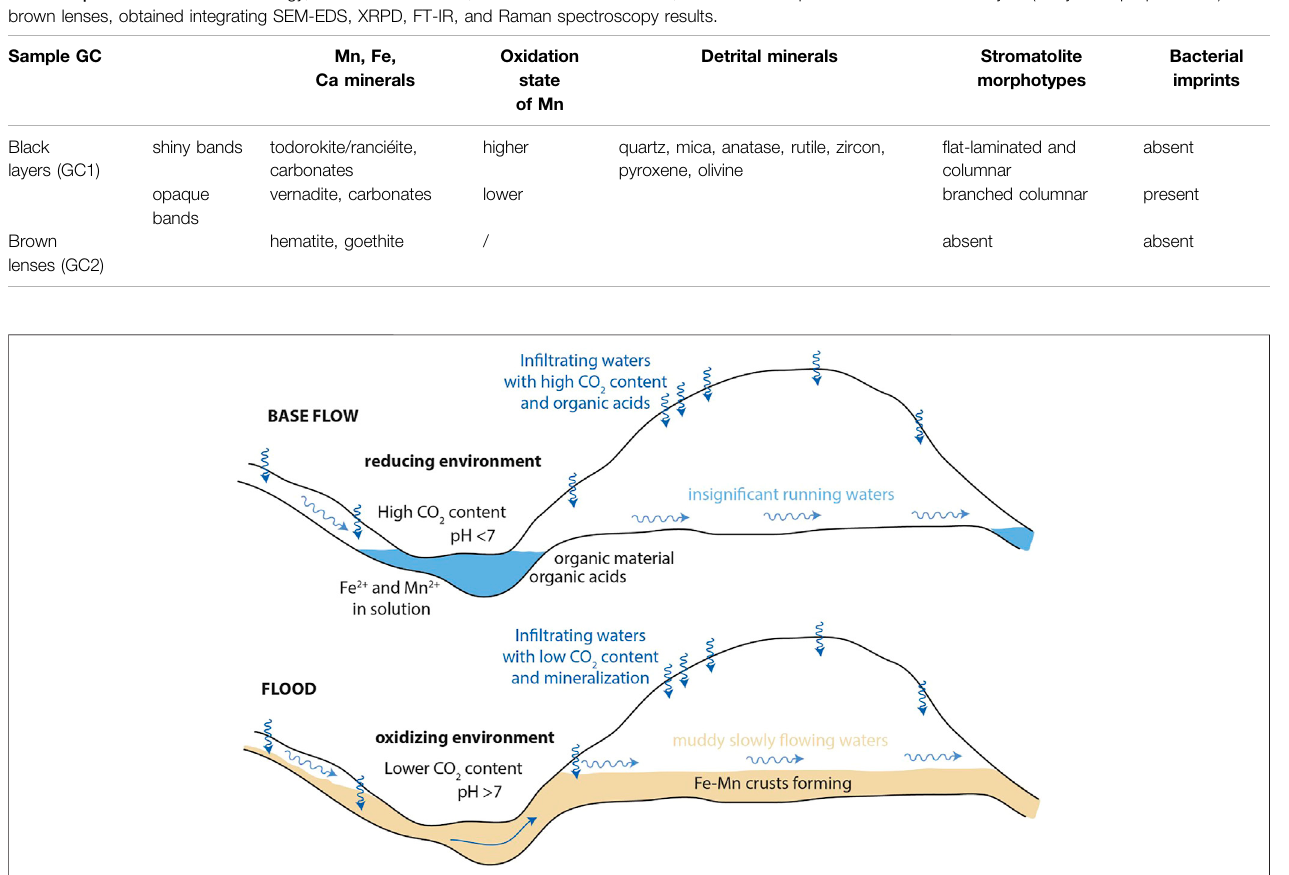
FIGURE12| DepositionalmodelproposedfortheMnFepatinas.Duringbase fl owhydrologicalconditions(upperpanel),thestudiedkarstsystemdrainsin fi ltrating waterwithnosigni fi cantincreaseofundergroundwaterlevel.Patinasformduringrecurrent fl oodsaccordingtohydrological-drivenchangesongeochemicalparameters and depositional conditions as explained within the